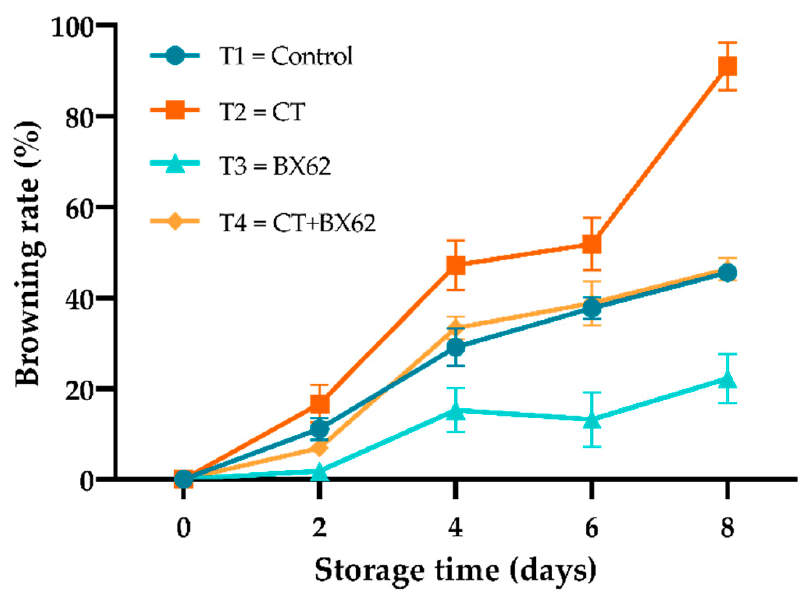
Figure 2. Changes in browning rate for the control apples ( ● ), chitosan-treated apples ( ■ ), L. planta- rum BX62-treated apples ( ▲ ), and chitosan in combination with L. plantarum BX62-treated apples ( ◆ ) after being stored at 4 °C for 8 days. Each data point is the mean of three replicate samples.